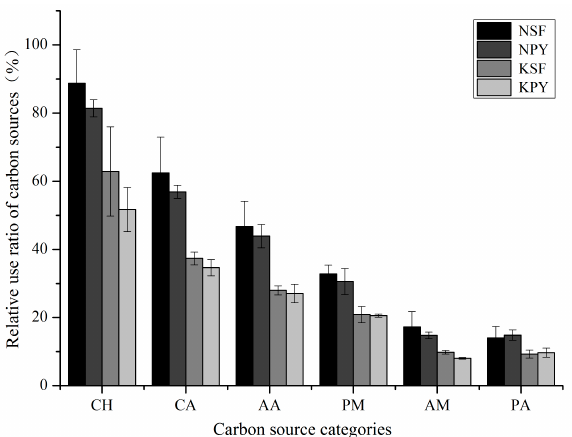
Figure 1. The relative use ratio of six carbon substrate categories for the two vegetation types in